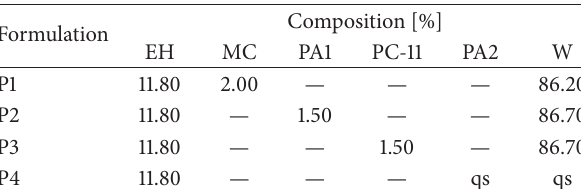
Table 1: The composition of the prepared gels comprising EH and different